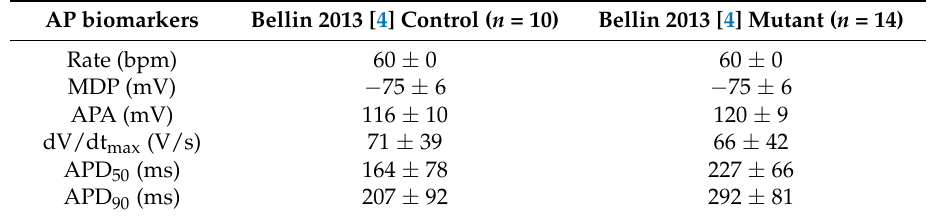
Table 3. AP biomarkers measured in control and mutant hiPSC-CMs paced at 60 bpm by Bellin et al. [4]. AP biomarkers are expressed as mean ± SD. APA: AP amplitude. APD 50 and APD 90 : AP duration at 50% and 90% of repolarization, respectively. dV/dt max : maximum upstroke velocity. MDP: maximum diastolic potential. Peak: peak voltage. Rate: stimulation